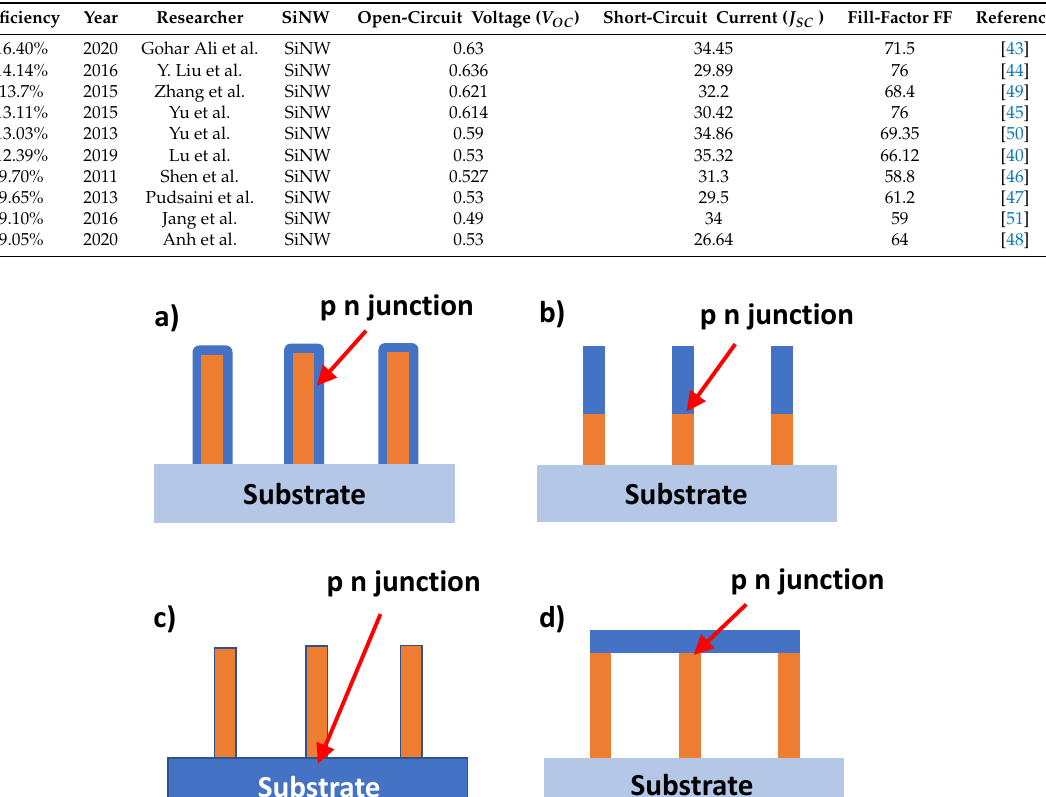
Table 1. The performance parameters for the top ten reported PEDOT:PSS–SiNW hybrid solar cells, where in all references metal assisted chemical etching (MACE) fabrication technology and radial p-n junction types are used.